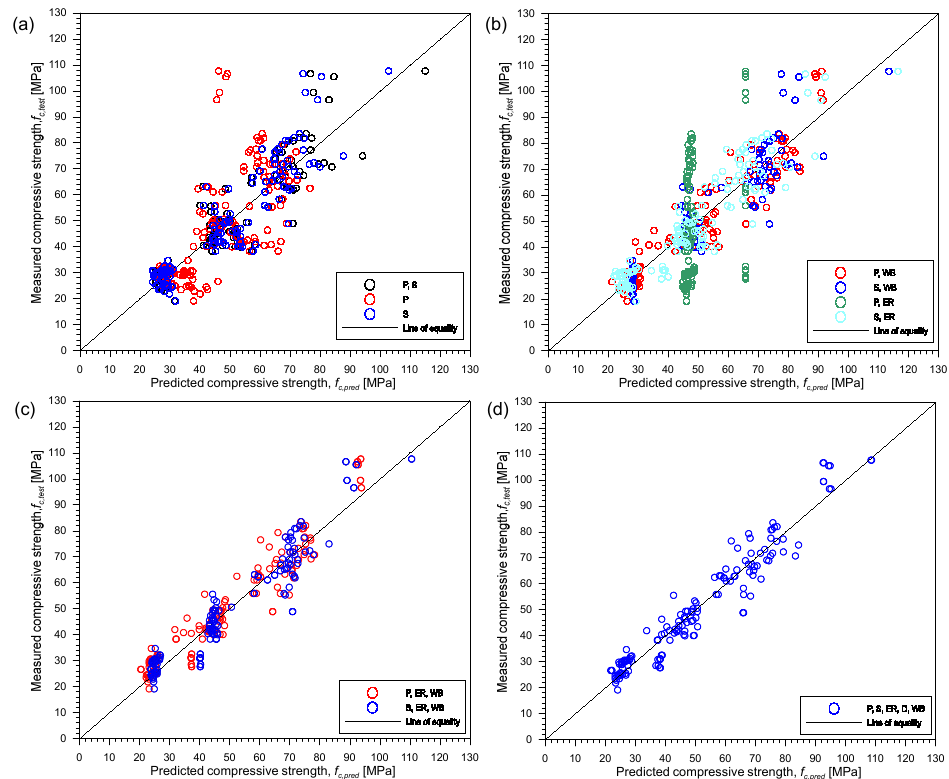
Figure 8. Correlation between actual f c,test and predicted f c,pred using different combinations of the five parameters from multivariate regression analysis: ( a ) only UPV parameters: P, S, or P and S, ( b ) combination of UPV and one other parameter: P and WB, S and WB, P and ER, or S and ER, ( c ) combination of UPV, ER and WB: P, ER and WB, or S, ER and WB and ( d ) five all parameters: P, S, ER, D and WB. Note—S: S-wave velocity, P: P-wave velocity, ER: electric resistivity, D: density and WB: water-to-binder ratio.